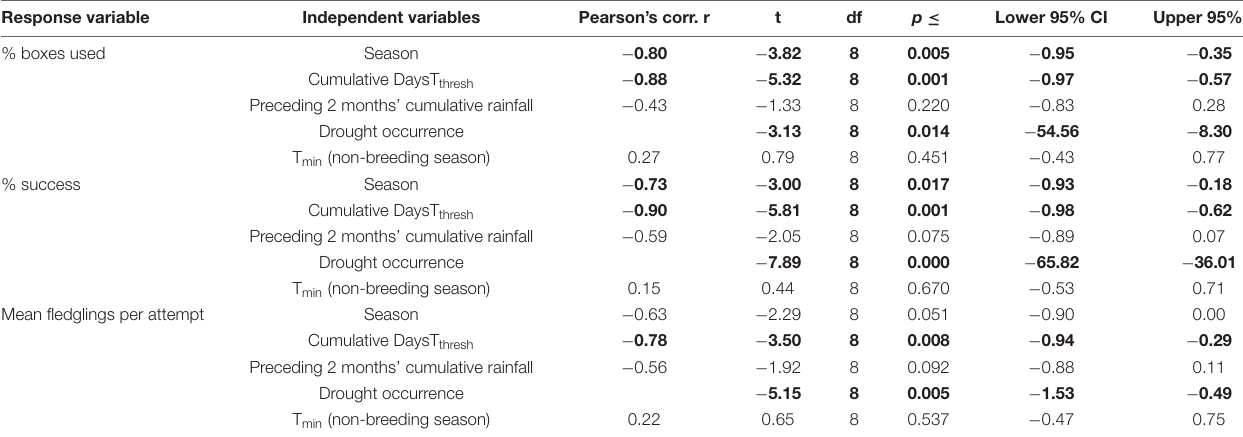
TABLE 1 | Pearson’s correlation test results for the percentage of boxes used, percentage of attempts fledging at least one chick, and mean fledglings per attempt per season in the southern yellow-billed hornbills ( Tockus leucomelas ), correlated with the cumulative DaysT thresh {days on which T max [mean maximum daily air temperature (T air )] > T thresh (T air = 34.5 ◦ C)} within the breeding season (19 October–24 March), T min (mean minimum daily T air ), and cumulative rainfall within the 2 months prior to the start of the breeding season (18 August–18 October each year).